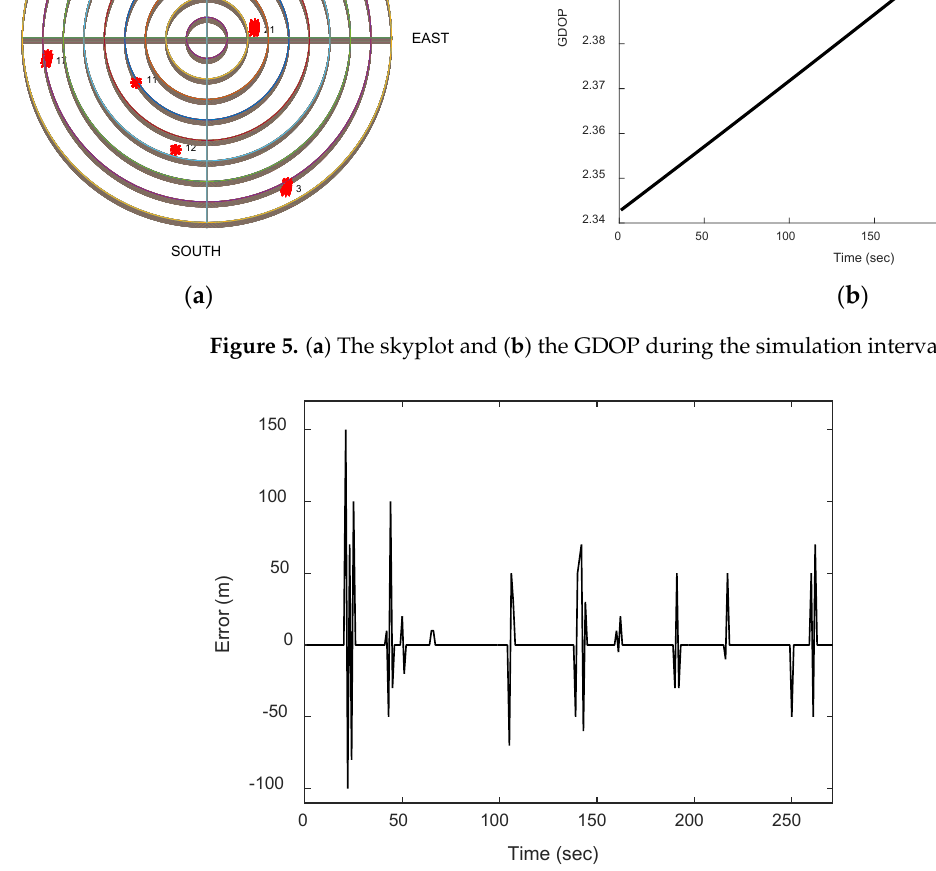
Figure 6. Information for the sequences of outlier interferences.